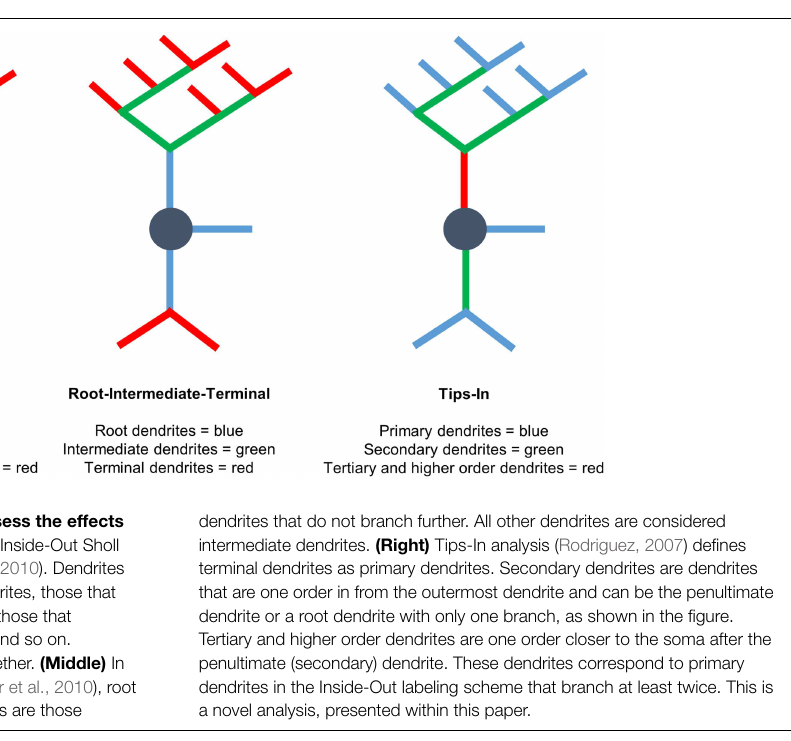
FIGURE 1 | Three different Sholl analyses used to assess the effects of cypin overexpression on the dendritic arbor. (Left) Inside-Out Sholl analysis is conventional Sholl analysis (Langhammer et al., 2010). Dendrites that extend from the cell body are defined as primary dendrites, those that emanate from primary dendrites are secondary dendrites, those that emanate from secondary dendrites are tertiary dendrites, and so on. Dendrites classified as tertiary and higher are grouped together. (Middle) In the Root-Intermediate-Terminal (RIT) scheme (Langhammer et al., 2010), root dendrites emerge from the cell body, and terminal dendrites are those